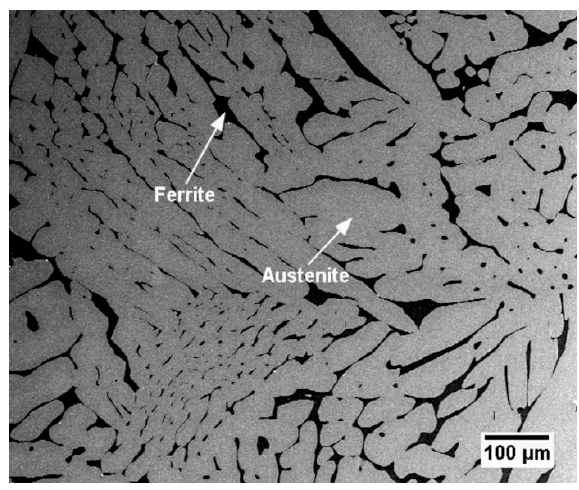
Figure 1. Typical microstructure of the Z3CN20.09M cast duplex stainless steel.